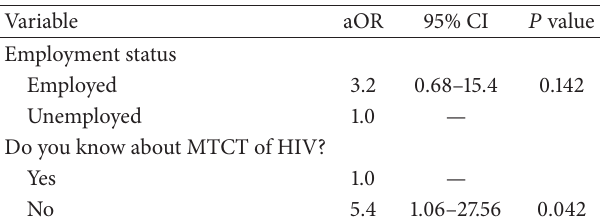
Table 8: Risk factors for HIV seroconversion in a multivariate model.